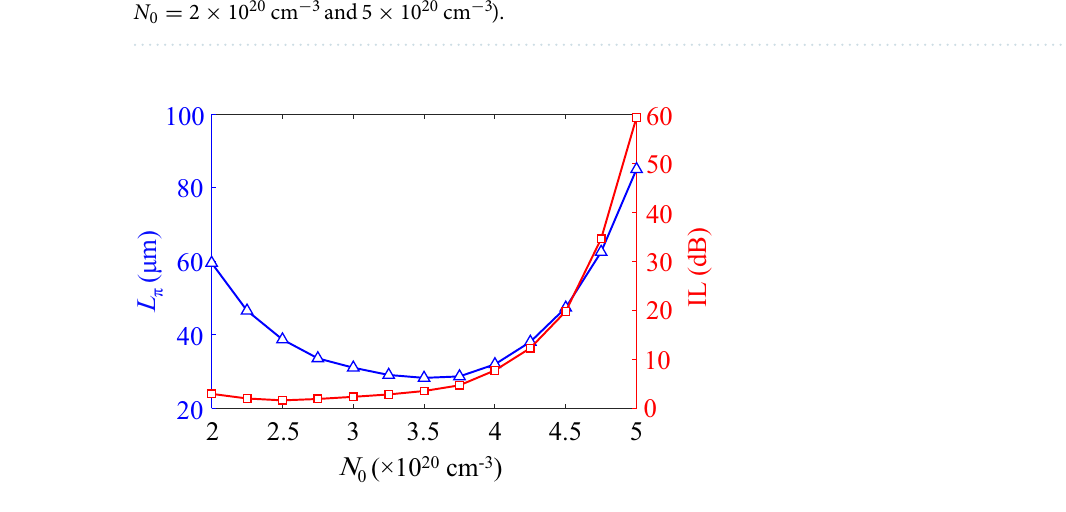
Figure 4. Required arm length for π phase shift and its associated IL as functions of ITO initial